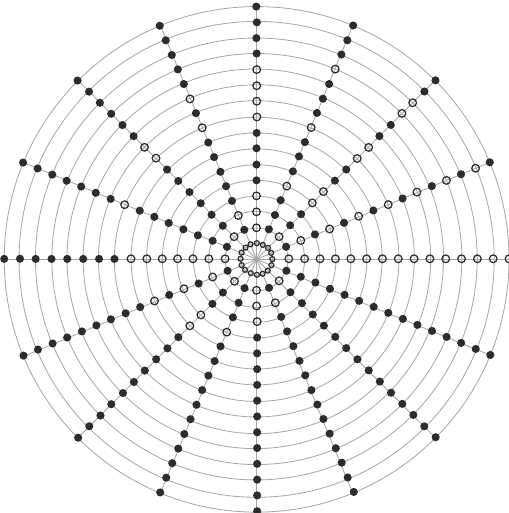
Figure 8: Cartesian (𝑥,𝑦) coordinate system converted into polar (𝑟, 𝜃) system, where 𝑟 = 𝑥 , 𝜃 = 2𝜋𝑦/(2 𝑛 − 1) , and 𝑥, 𝑦 ∈ [0, 2 𝑛 − 1] . Filled circles indicate the “redundant